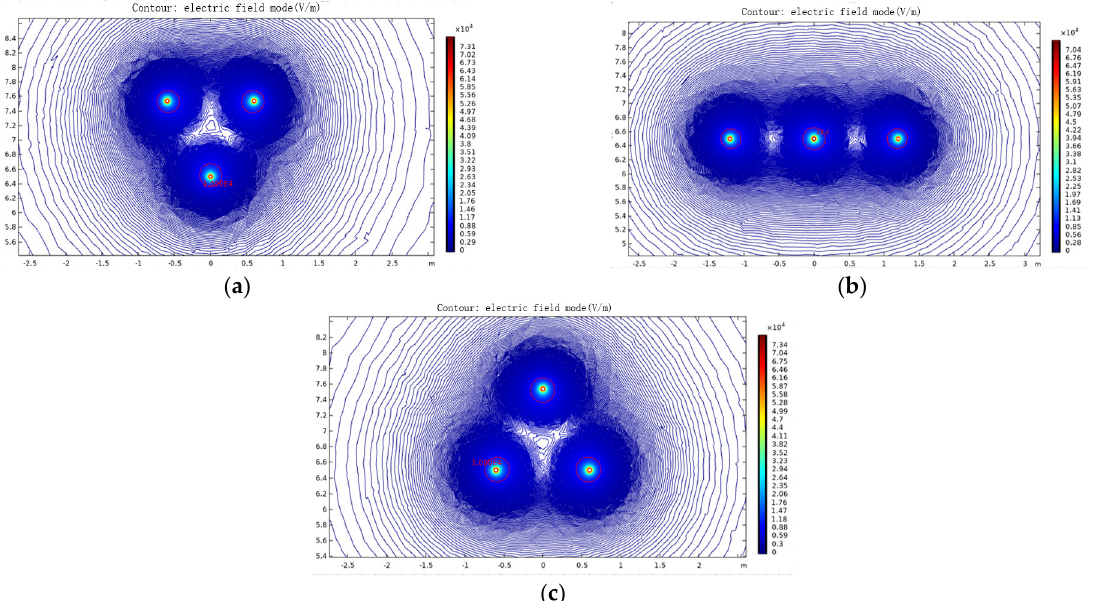
Figure 3. Electric field distribution around transmission lines with different arrangements of 10 KV voltage levels. ( a ) Field strength distribution under 10 kV inverted triangle arrangement; ( b ) field strength distribution under 10 kV horizontal arrangement; ( c ) field strength distribution of 10 kV regular triangle.